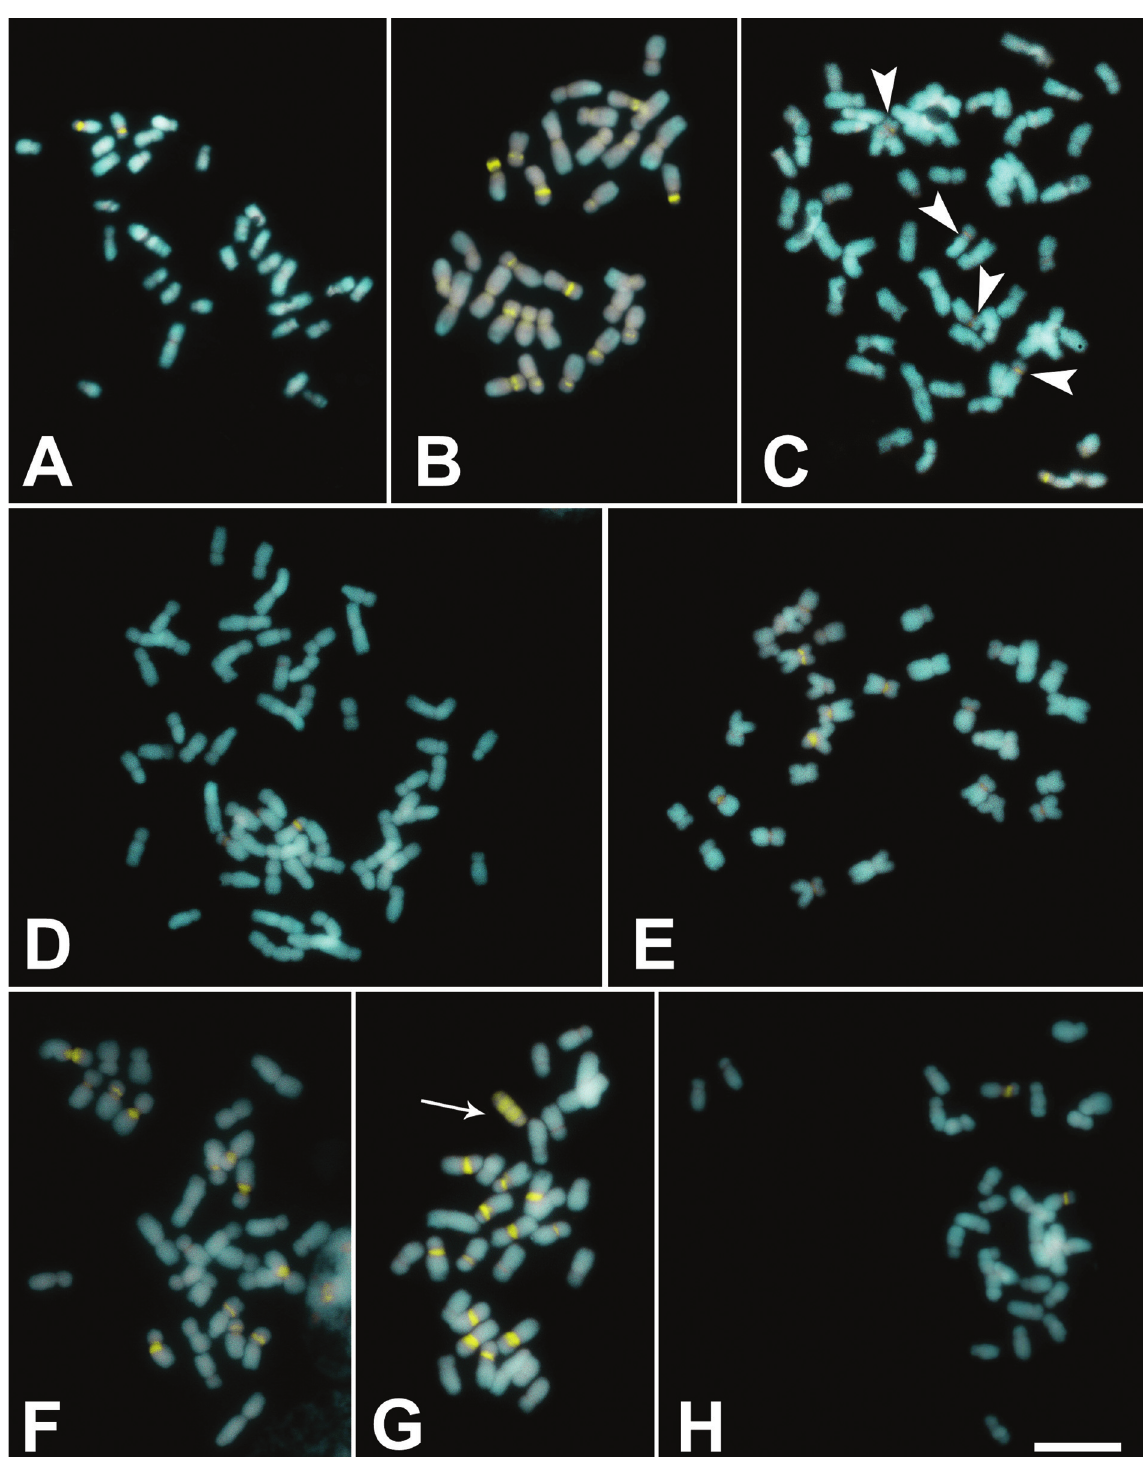
Figure 2 - Metaphases of Anthurium species under CMA/DAPI staining. (A) Anthurium jilekii with 2 n = 30; (B-D) A. pentaphyllum , Meruoca-CE popu- lation with 2 n = 30 (B), Mamanguape-PB (C) and Itabaiana-SE populations (D), both with 2 n = 60; (E-G) A. petrophilum , Buíque-PE population (E) and Brejo da Madre de Deus-PE population (F), with 2 n = 30 and São João do Tigre-PE population (G) with 2 n = 30+1B; H. Anthurium sp. (2 n = 30). Arrows in G show B chromosomes; arrow heads in C show chromosomes with CMA bands. Bar in H is equivalent to 10 (cid:2)